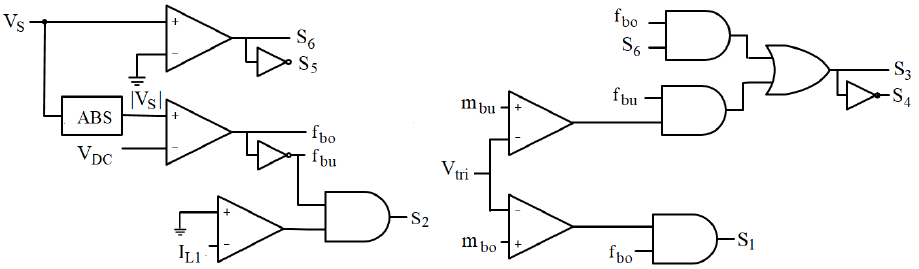
Figure 7. Block of logic and PWM circuit.